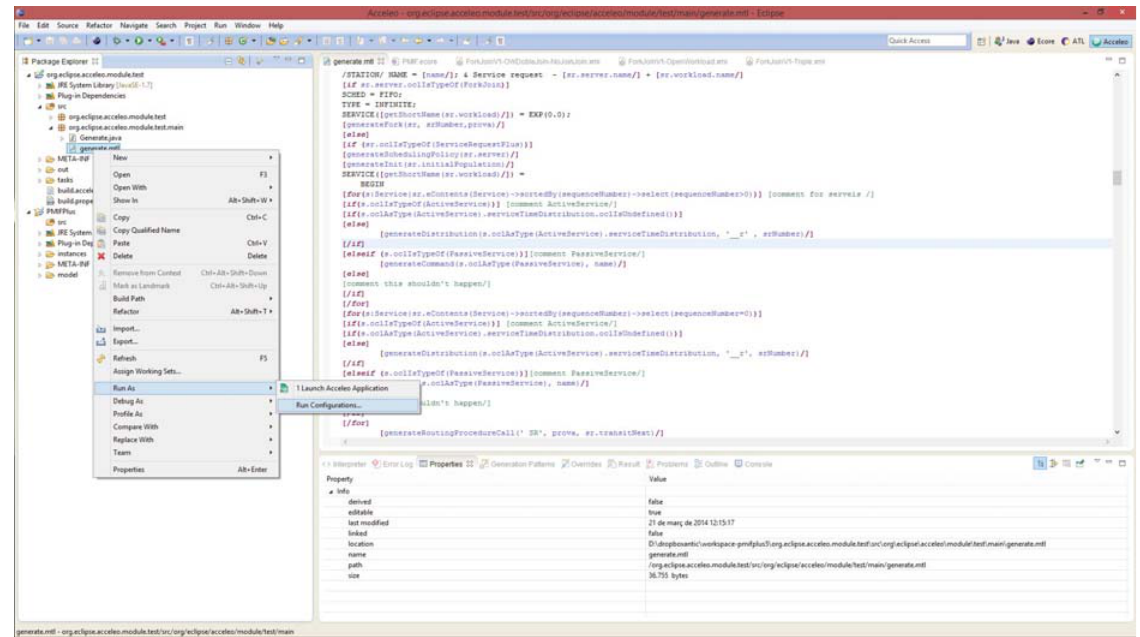
Figure 2: Execution of a transformation with Acceleo